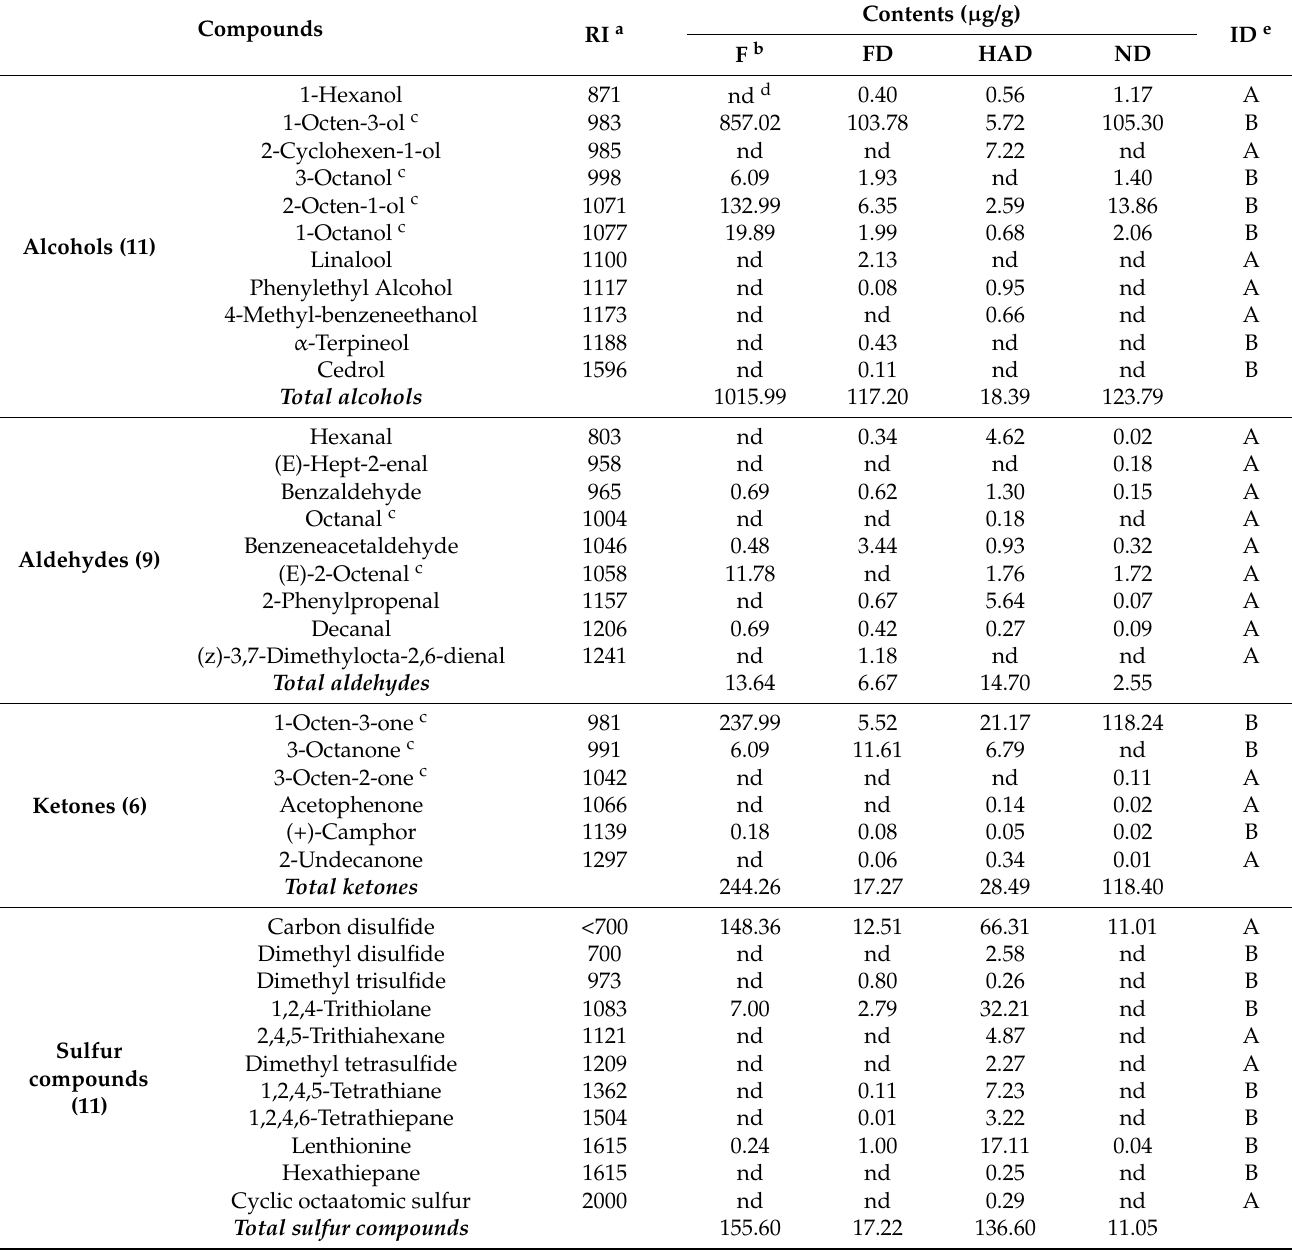
Table 1. Contents of volatile compounds in fresh and different dried L. edodes